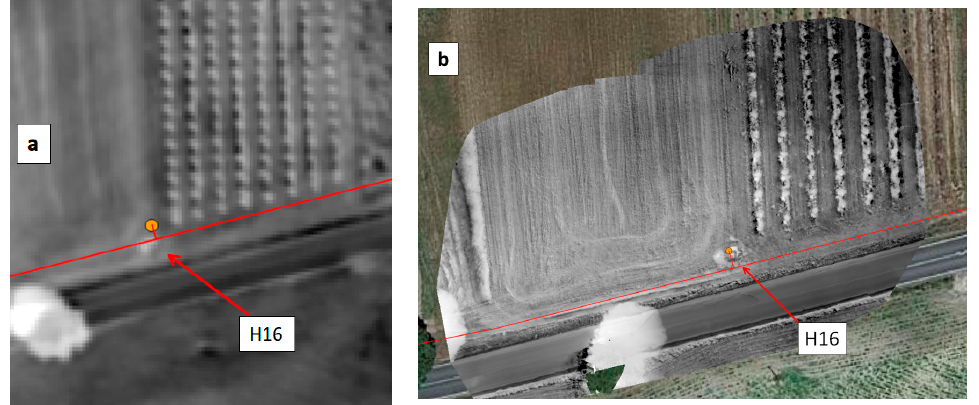
Figure 23. WI images (in greyscale) showing the artificial leak at hydrant H16 as obtained on 12 September 2019 with ( a ) the MAV (excerpt from Figure 22a) and ( b ) the UAV. The water distribution network is overlaid in red.